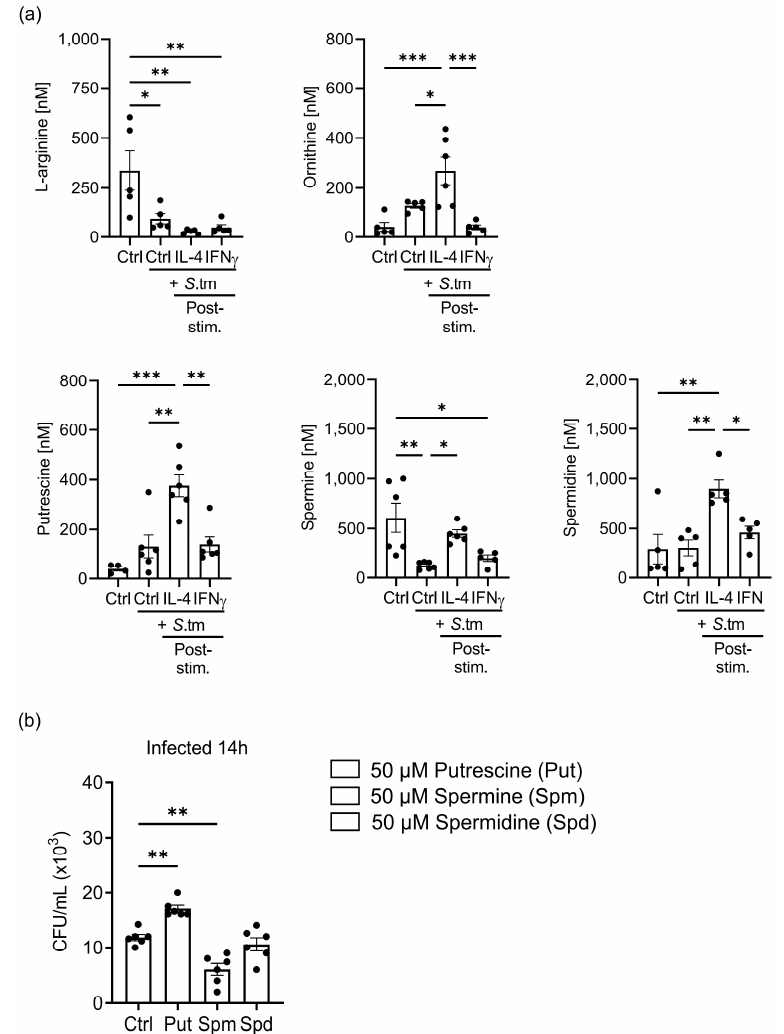
Figure 8. IL-4 stimulation of unpolarised macrophages after infection with S .tm alters L-arginine metabolic pathways with direct impact on the growth of Salmonella . Unpolarised BMDM were infected with S .tm for 1 h. Afterwards, cells were stimulated (post-stimulation) with 10 ng/mL IL-4, 100 ng/mL IFN γ or left unstimulated as indicated. ( a ) Concentrations of L-arginine and related metabolites determined by LC-MS/MS in 24 h post-stimulated BMDM cell lysates. ( b ) Growth of S .tm after 14 h in media supplemented with either 50 µ M spermine, 50 µ M spermidine or 50 µ M putrescine. Statistical significance was determined by one-way ANOVA with Tukey post hoc test. * p -value < 0.05; ** p -value < 0.01; *** p -value < 0.001. Representative data (mean ± SEM) of